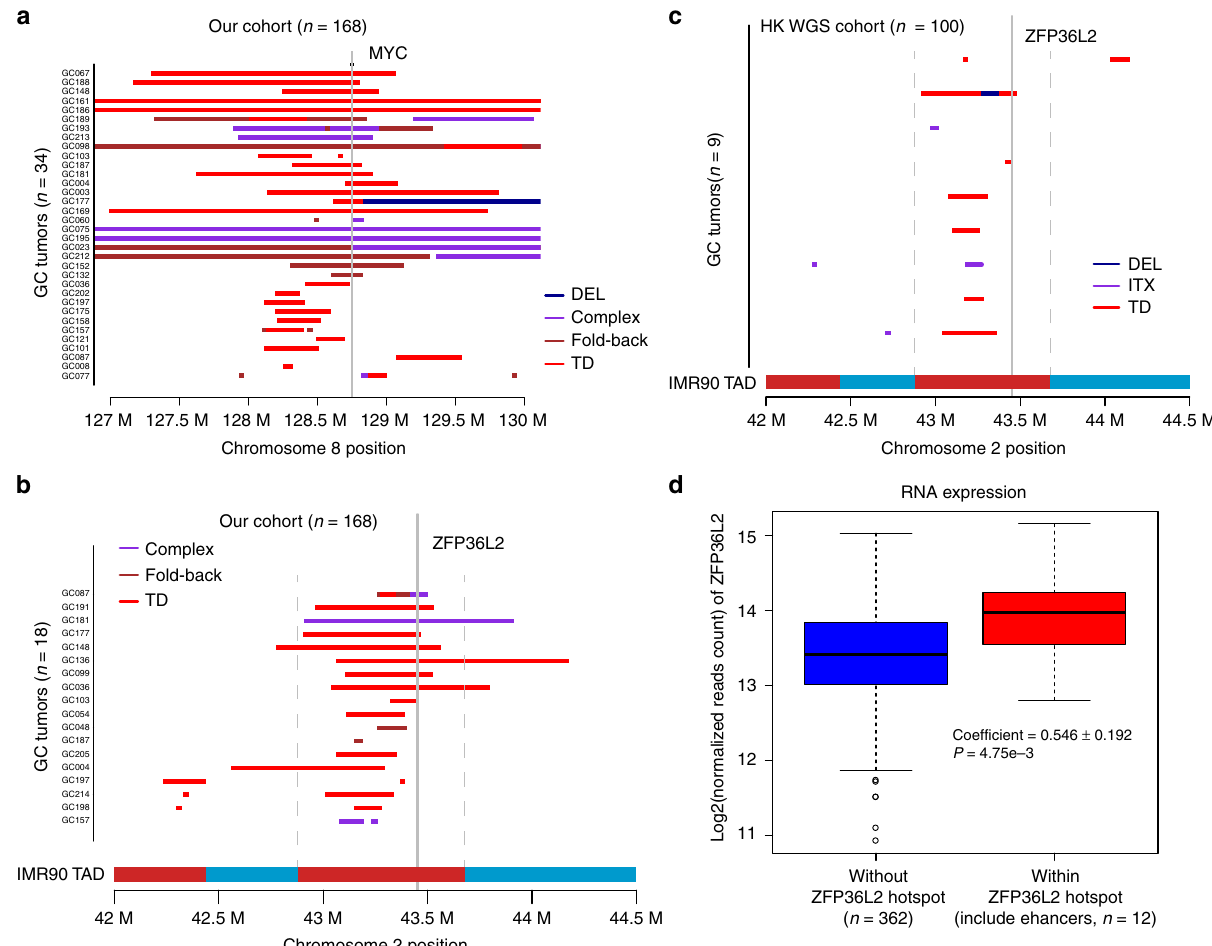
Fig. 4 Ampli fi cation of ZPF36L2 and MYC super-enhancers. a Rearrangements localized in the MYC -coding and -enhancer regions. b Rearrangements localized in the ZPF36L2- coding and neighboring-noncoding regions. Chromatin interaction, measuring by Hi-C in the cell line IMR90, is presented in the vicinity of ZFP36L2 locus. The topologically associated domains (TAD) are shown as adjacent red and blue bars. c Validation of TD-induced ampli fi cation of ZFP36L2 super-enhancers in an HK WGS cohort ( n = 100). d Comparison of ZFP36L2 expression between samples with or without focal ampli fi cation in the TCGA GC cohort. Center line represents the median of mRNA expression and P value was derived from Wilcoxon rank-sum test. TD